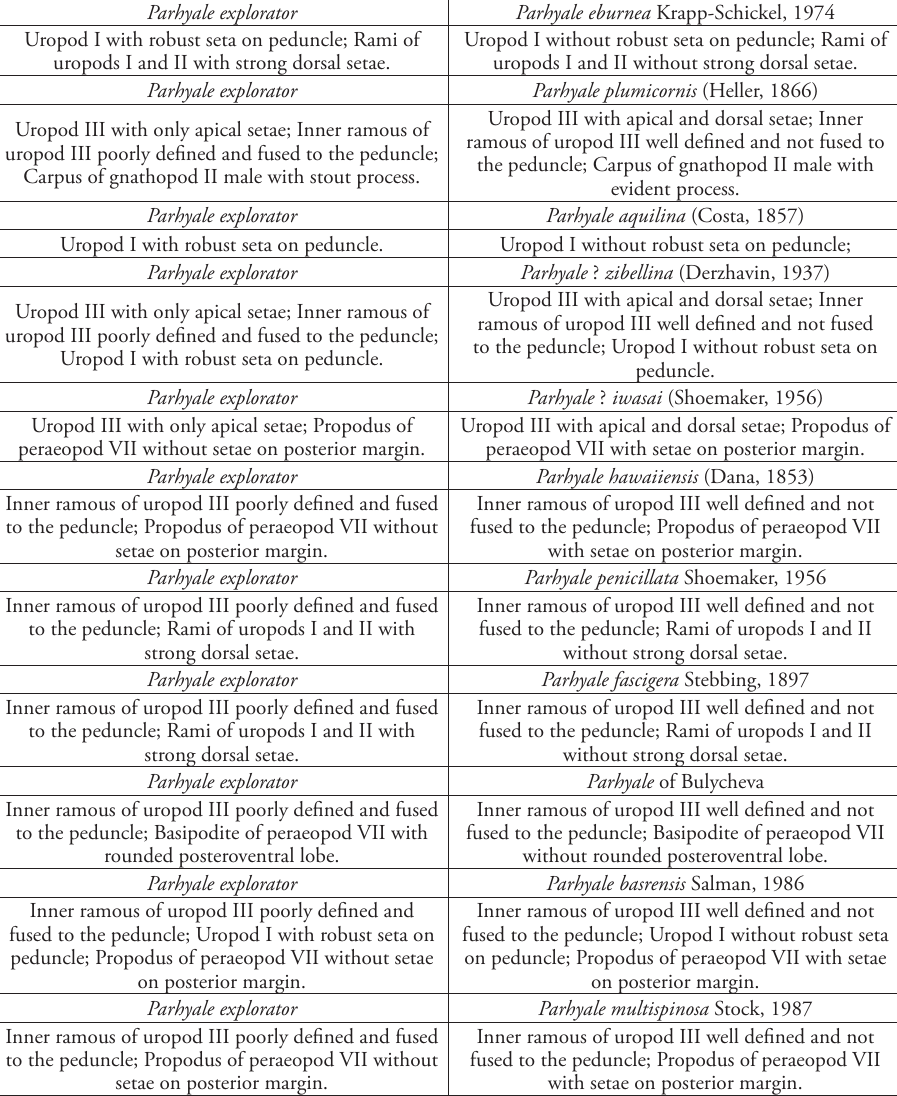
Table 3. Characters used by Arresti (1989) for diagnosing Parhyale explorator (subsequently synonymised Ptilohyale explorator ) from the other species of the genus Parhyale